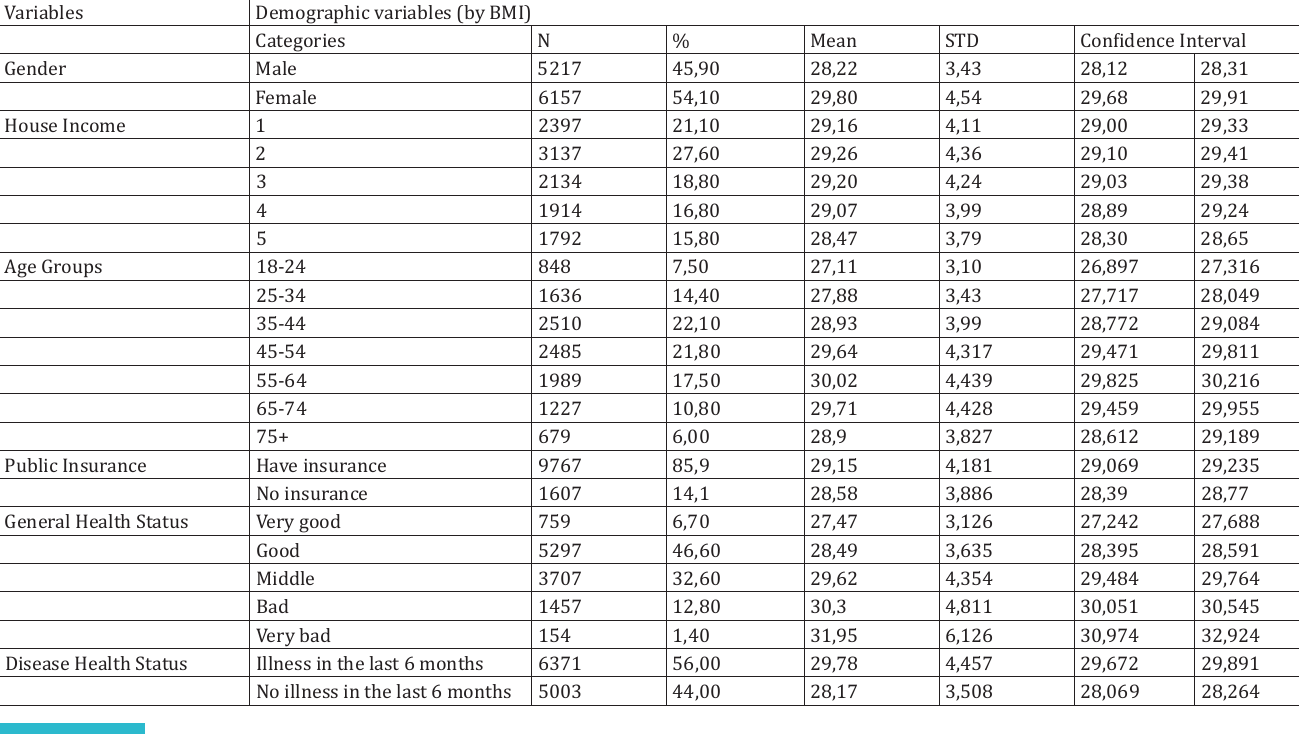
Table 1 Mean, std and confidence interval values of demographic variables according to number, ratio and BMI